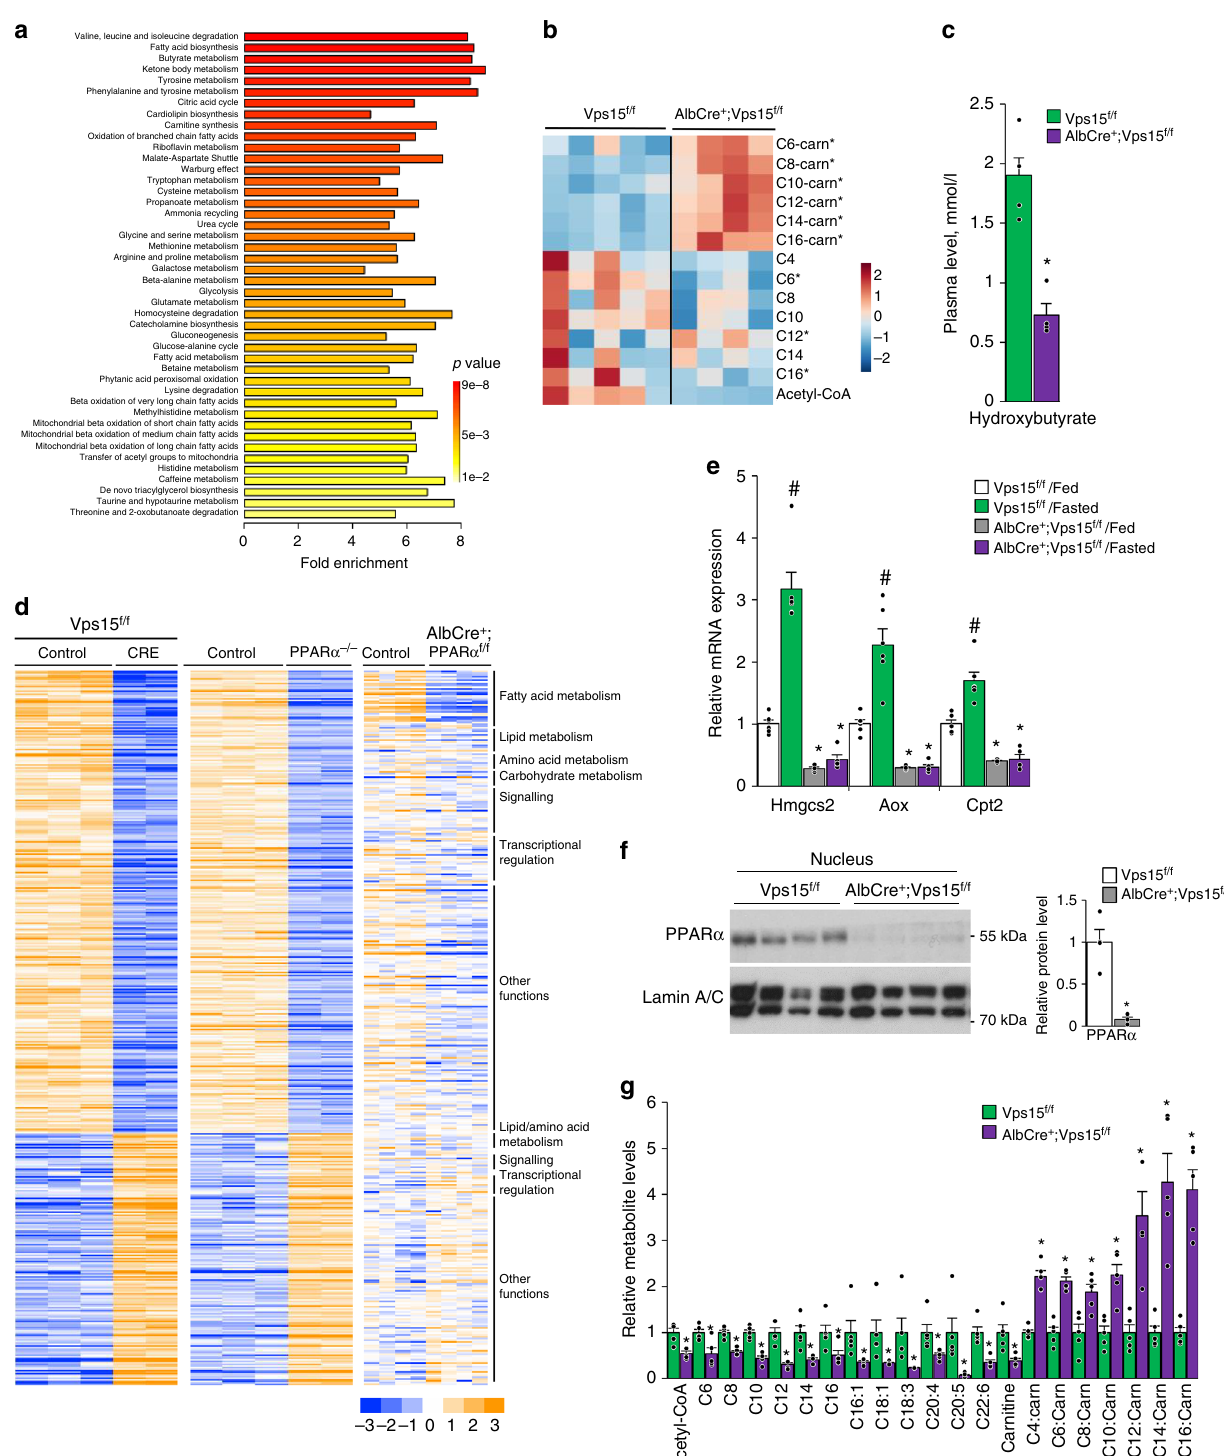
the levels of circulating glycerol and non-esteri fi ed free fatty acids were increased in plasma of control mice (Supplementary Fig. 4e). statistical signi fi cance in the plasma of fed Vps15-LKO mice (P value of 0.059, unpaired two-tailed Student ’ s t-test) and fasting further lowered it in both genotypes (Supplementary Fig. 4e). Adipose tissue lipolysis is a major source of circulating fatty acids in fasting. Consistent, 24-h starvation resulted in a decrease in whole body adipose tissue content measured by dual energy X-ray absorptiometry (DEXA) scan in control and Vps15-LKO mice. In NATURE COMMUNICATIONS| (2019) 10:1566